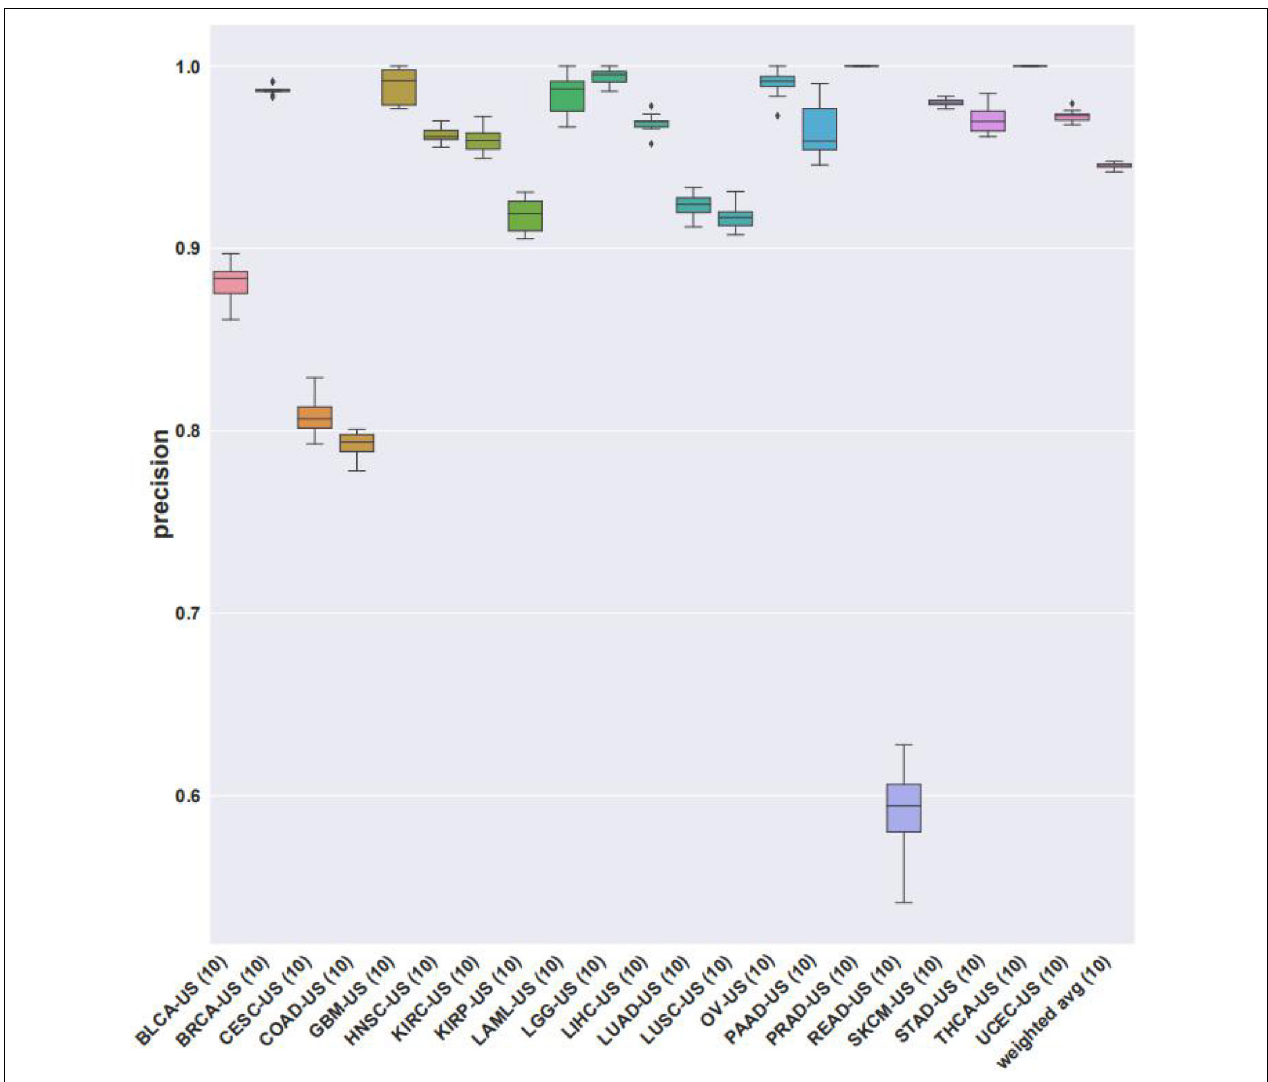
FIGURE 4 | The precisions of XGBoost classifier using gene expression data on the 14 top-ranked genes for each cancer type. Precisions from 10 times of cross-validations were